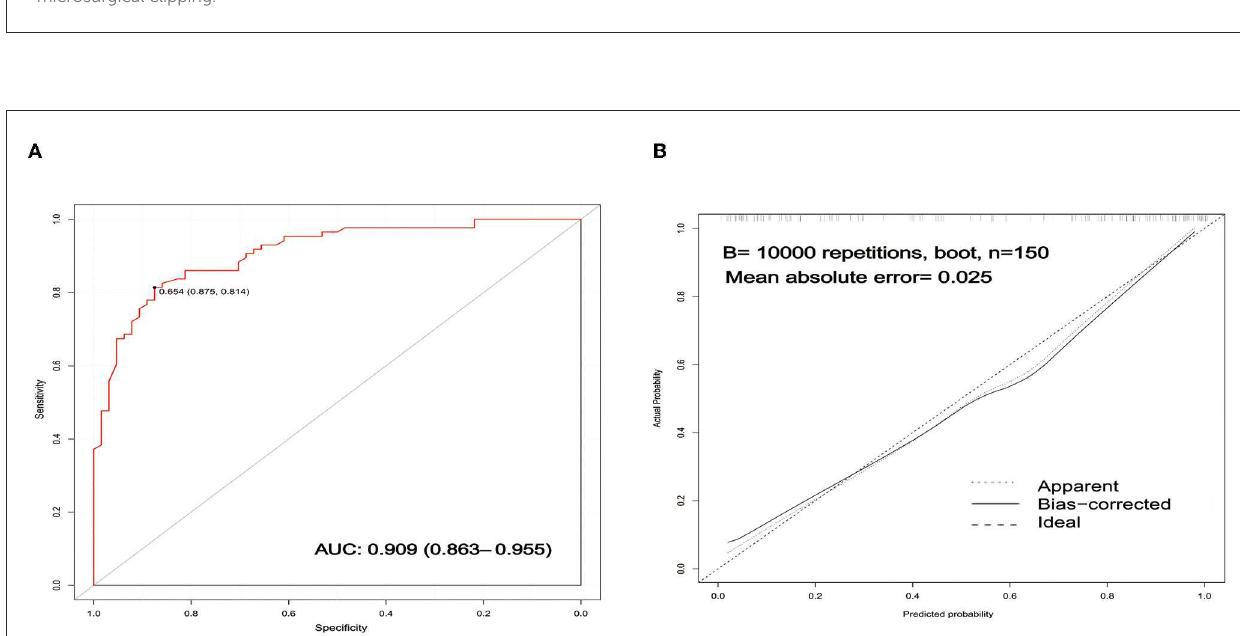
FIGURE2 The nomogram model for predicting the risk of poor prognosis in patients with poor-grade aneurysmal subarachnoid hemorrhage following microsurgical clipping.